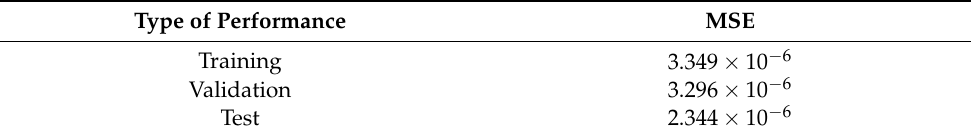
Table 8. Performances for Case B performed by using a different command curve (Figure 15).